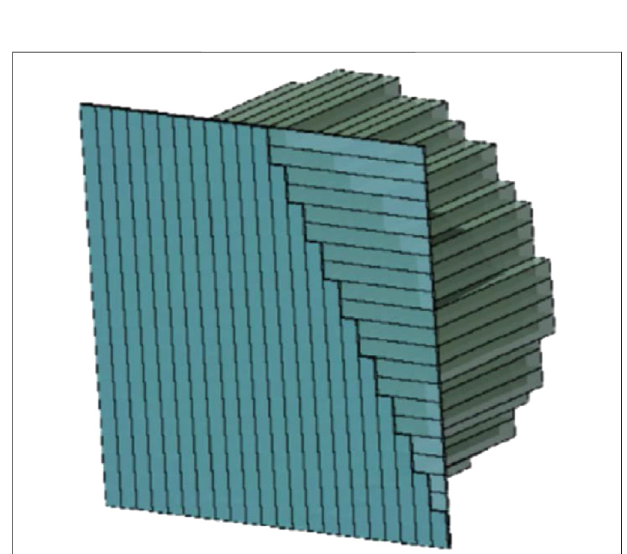
FIGURE 5 | Schematic view of the fragment identi fi cation region. The two orthogonal layers of 20 plastic scintillator bars are shown in front of the matrix of BGO crystals used to build the